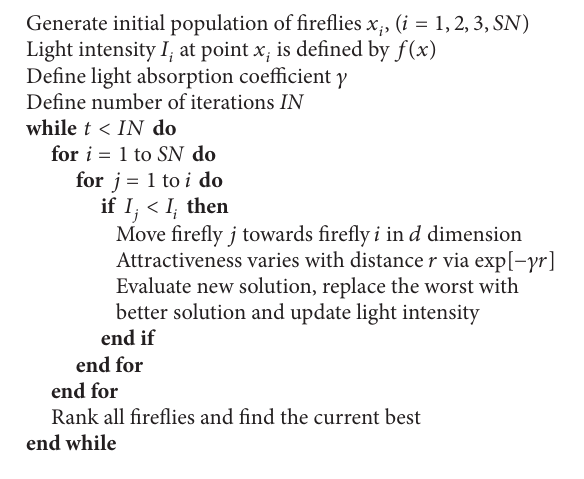
Algorithm 1: Original firefly